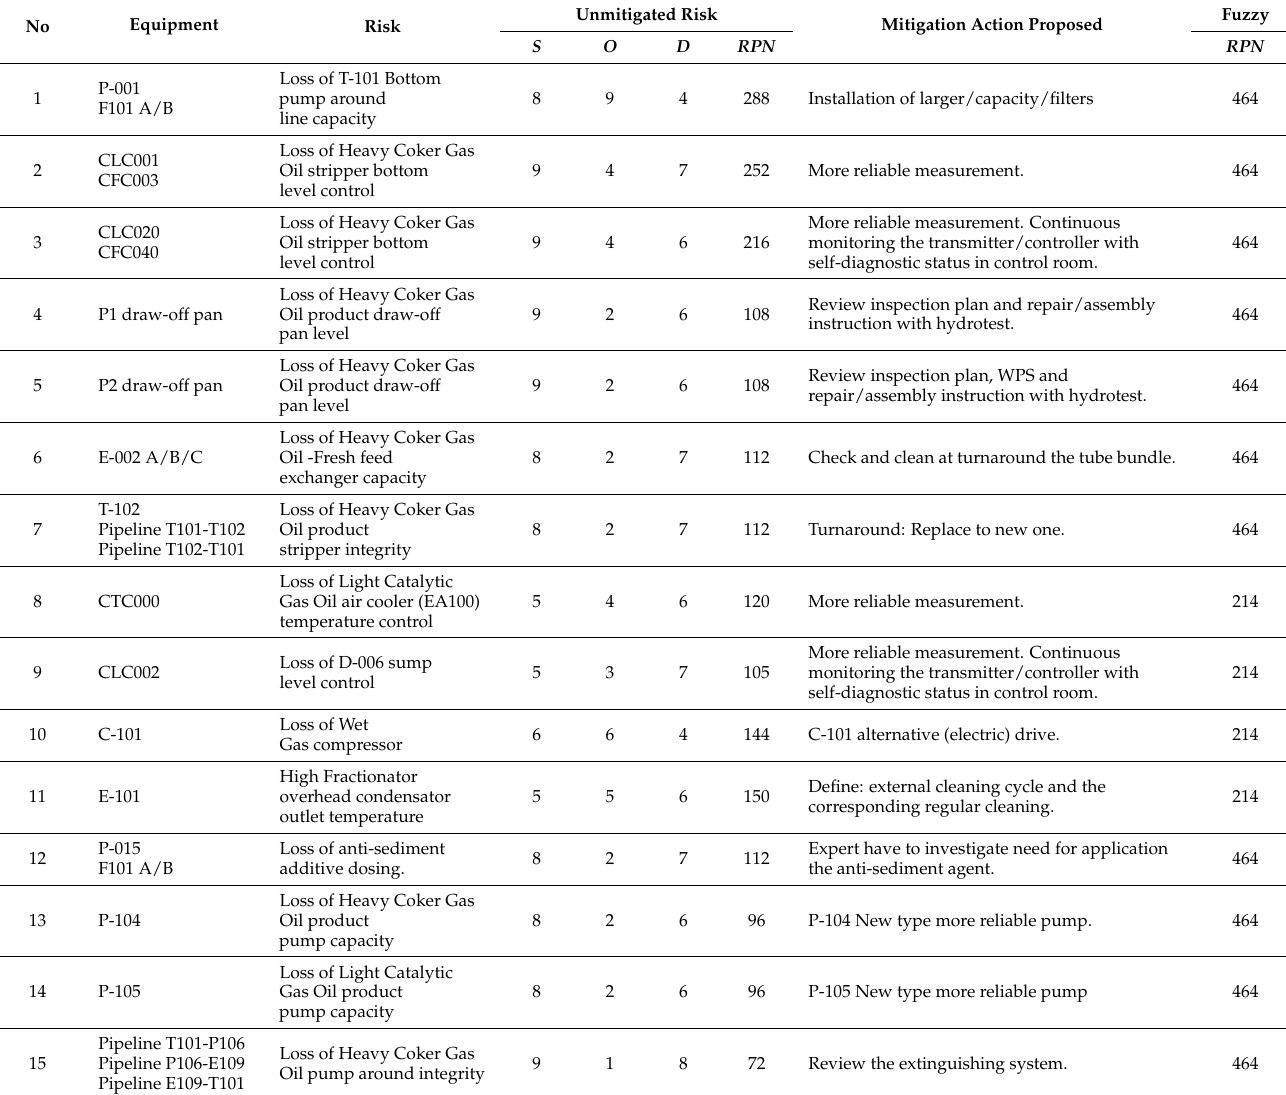
Table 8. FMEA results for high risks observed